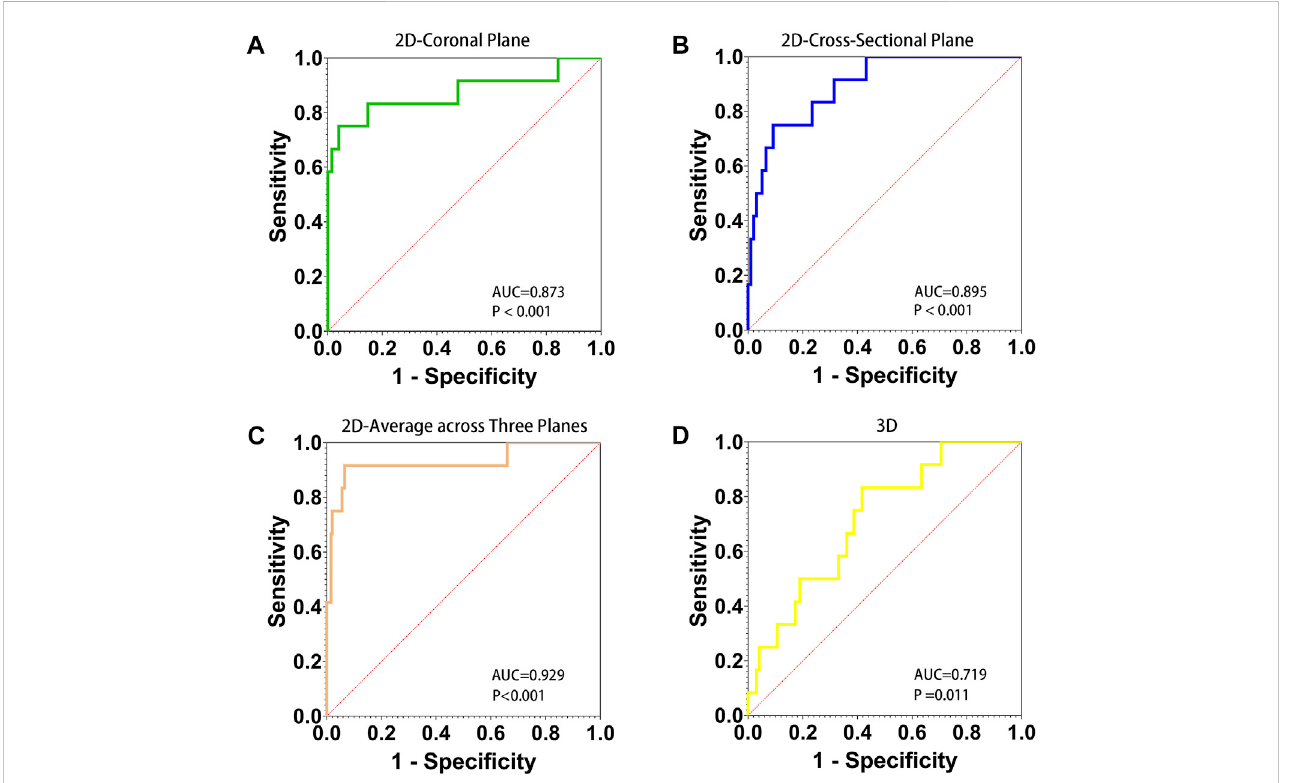
FIGURE 3 AUC, area under the ROC curve. Receiver operating characteristic (ROC) curve for 2D and 3D parameters to predict refracture of the femoral neck after femoral head fractures. The diagnostic accuracy of 2D parameter of the percentage of maximum defect length of coronal plane (A) , cross-sectional (B) , average across three planes (C) , and 3D parameter of the percentage of fracture area (D) was shown.